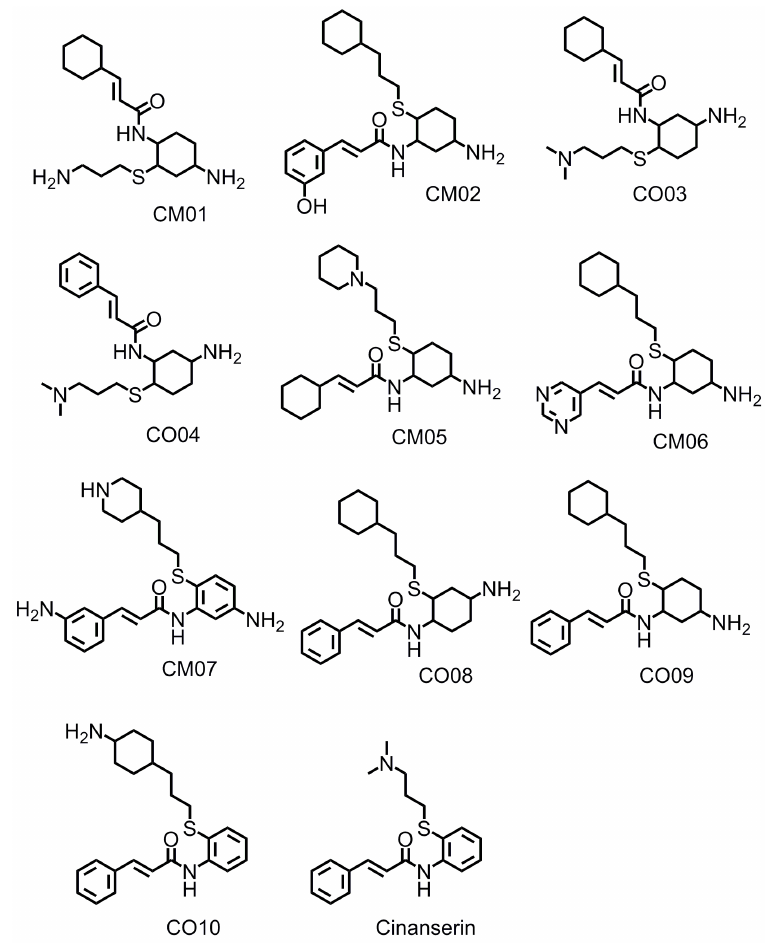
Figure 17. Cinanserin and optimized cinanserin inhibitor